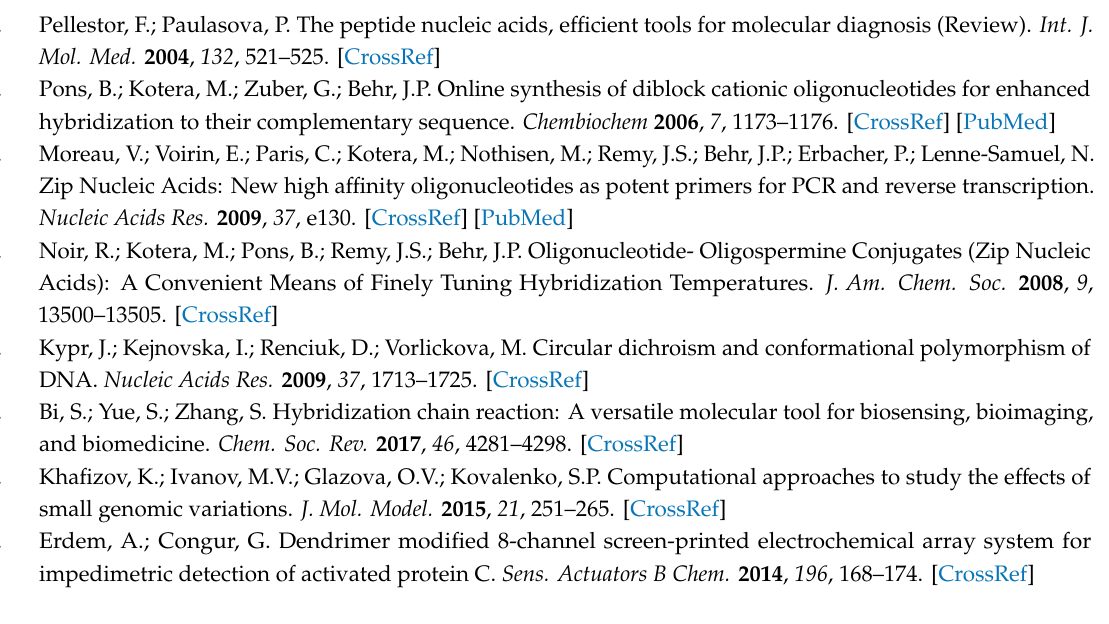
diagrams obtained by (a) CNF-SPE, (b) the pseudo hybridization of ZNA probe in ABS, (c) the hybridization of ZNA probe and mDNA target in ABS, (d) the pseudo hybridization of 5’ZNA probe in PBS, (e) the hybridization of ZNA probe and mDNA target in PBS, (f) the pseudo hybridization of ZNA probe in CBS, (g) the hybridization of ZNA probe and mDNA target in CBS. Inset was the equivalent circuit model used for fitting of the impedance data. Figure S5: The Nyquist diagrams obtained by (a) CNF-SPE, (b) the pseudo hybridization of ZNA probe during 5 min, (c) the hybridization of ZNA probe and mDNA target during 5 min, (d) the pseudo hybridization of ZNA probe during 10 min, (e) the hybridization of ZNA probe and mDNA target during 10 min, (f) the pseudo hybridization of ZNA probe during 15 min, (g) the hybridization of ZNA probe and mDNA target during 15 min. Inset was the equivalent circuit model used for fitting of the impedance data. Figure S6: Nyquist diagrams of (a) CNF-SPE, after the hybridization of (b) 0.5 µ g / mL, (c) 1 µ g / mL (d) 2 µ g / mL (e) 4 µ g / mL ZNA prob and 10 µ g / mL mDNA target. Inset was the equivalent circuit model used for fitting of the impedance data. Figure S7: Line graph representing the R ct values recorded by the hybridization of 1 µ g / mL ZNA probe with mDNA target at the concentration level from 0 to 14 µ g / mL. Table S1: The R ct values measured in the presence of the hybridization occurred between 1 µ g / mL ZNA probe and 10 µ g / mL mDNA target by single-use CNF-SPEs for three di ff erent days with the values of the average R ct and the standard deviation with the RSD% for presenting the intra-day reproducibility. Table S2: The R ct values measured in the presence of the hybridization occurred between 1 µ g / mL ZNA probe and 10 µ g / mL mDNA target by single-use CNF-SPEs for three di ff erent days with the values of the average R ct and the standard deviation with the RSD% for presenting the inter-day reproducibility. Table S3: The hybridization e ffi ciency (HE%) calculated based on the average R ct value obtained after the hybridization of ZNA probe (or DNA probe) with mDNA target / wDNA target in contrast to the average R ct value obtained in the presence of pseudo hybridization. Table S4: The hybridization e ffi ciency (HE%) calculated based on the average R ct value measured after the hybridization of ZNA probe with mDNA target / C-DNA / T-DNA / NC-1 / NC-2 in contrast to the average R ct value obtained in the presence of pseudo hybridization. Table S5: The hybridization e ffi ciency (HE%) calculated based on the average R ct value obtained after the hybridization of ZNA probe (or DNA probe) with mPCR-1 / mPCR-2 / wPCR-1 / wPCR-2 in contrast to the average R ct value obtained in the presence of pseudo hybridization. Table S6: The earlier studies developed for detection of Factor V Leiden mutation in contrast to the present